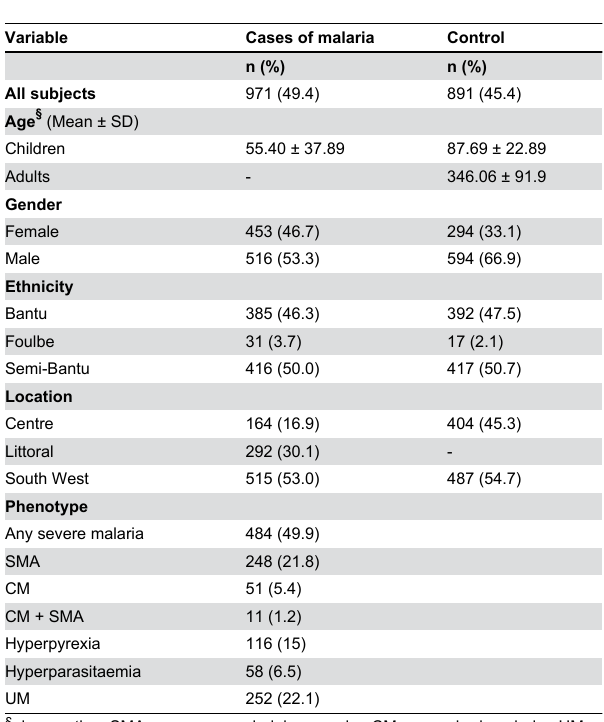
Table 1. Basic demographic and clinical characteristics of the study